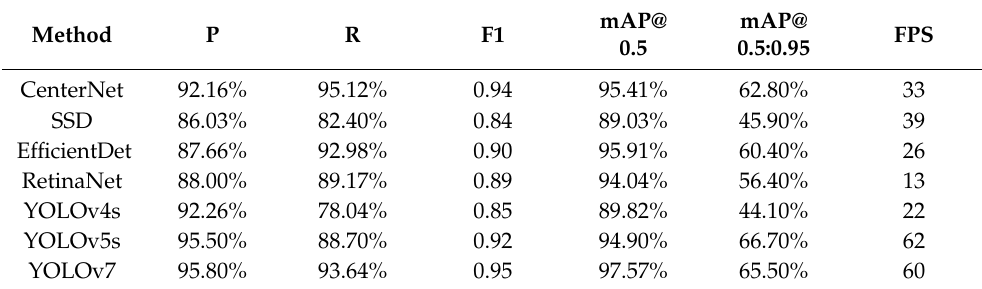
Table 2. Comparison of object detection